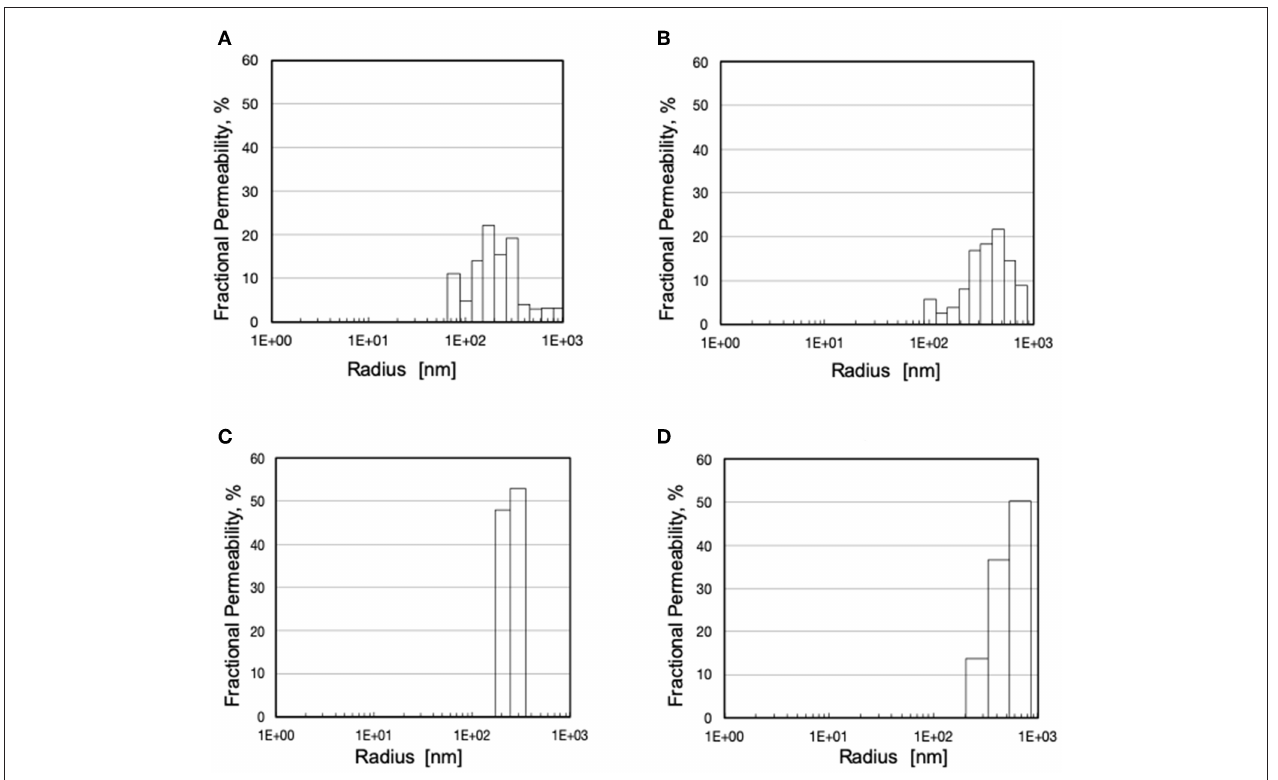
FIGURE 4 | Pore size distribution and fractional hydraulic permeability of various membranes: (A) Type I; (B) Type II; (C) Type III; (D) Type IV.